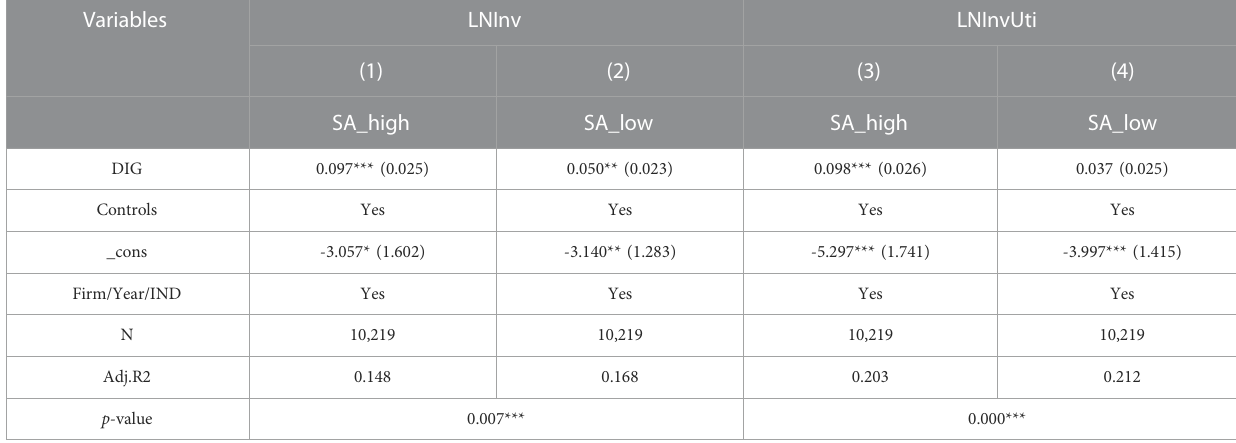
TABLE 14 Heterogeneity test based on fi nancing constraints.